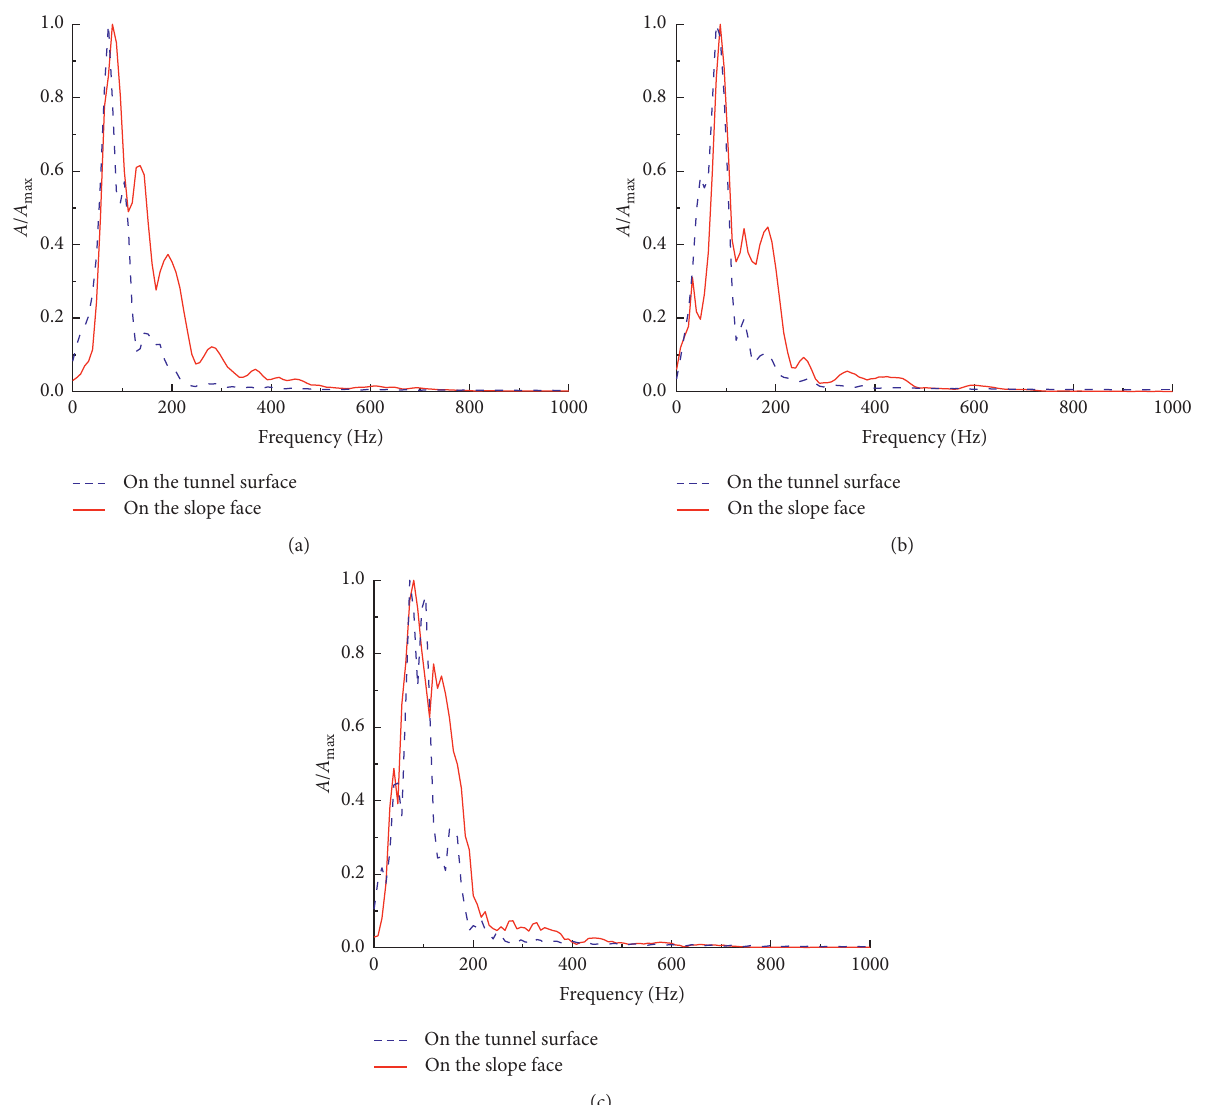
Figure 8: Amplitude-frequency spectra of the velocity histories recorded on the tunnel surface and slope face: (a) longitudinal component; (b) transverse component; (c) vertical